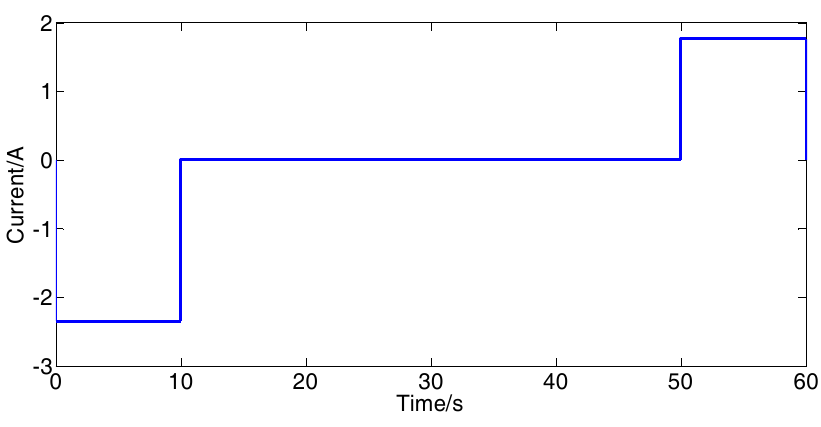
Figure 4. Hybrid pulse power characterization (HPPC) test current profile.